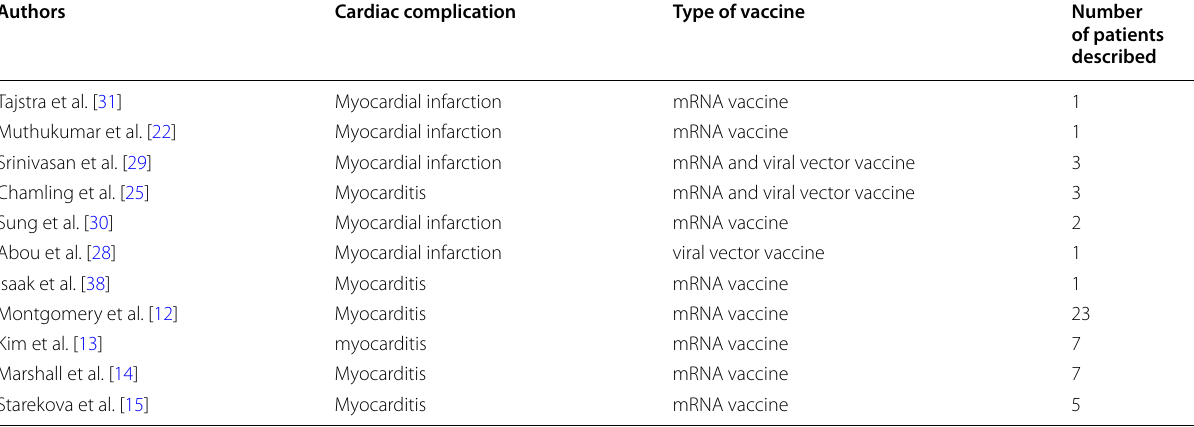
Table 1 summarized previous research regarding vac- cine-related cardiac